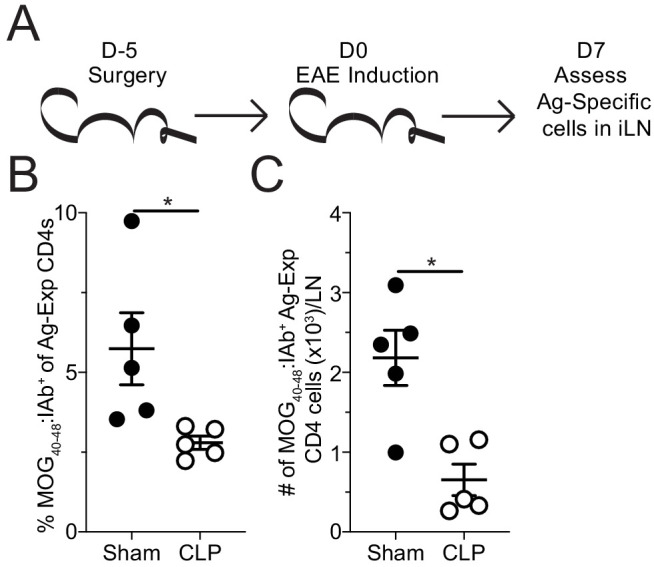
Sepsis reduces the number MOG-specific CD4 T cells present in sites of T cell priming following EAE induction.(A) Experimental design: C57Bl/6 mice underwent sham or CLP surgery. EAE induction occurred 5 days after surgery. Draining inguinal lymph nodes (iLN) were harvested 7 days after EAE disease induction. (B) Frequency and (C) number of MOG-specific CD4 T cells in the iLN of sham and CLP mice. Data are representative from three independent experiments with five mice per group. *p<0.05. Error bars represent the standard error of the mean.
Figure 4—source data 1.Source data for Figure 4.